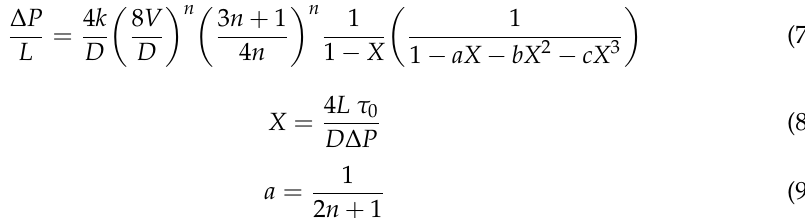
Table 6. Consistency value k and flow Index value n for type2 fluids. Sr.